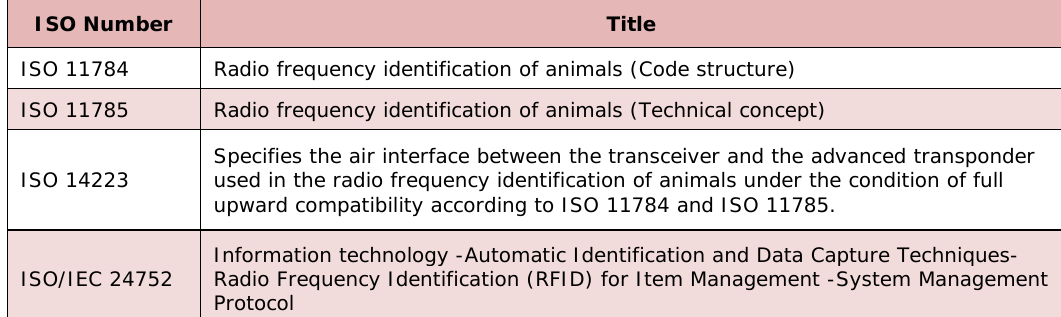
Protocol Table 2. “Examples of RFID standards”. Source: The RFID Network (http://rfid.net/) and the RFID Journal